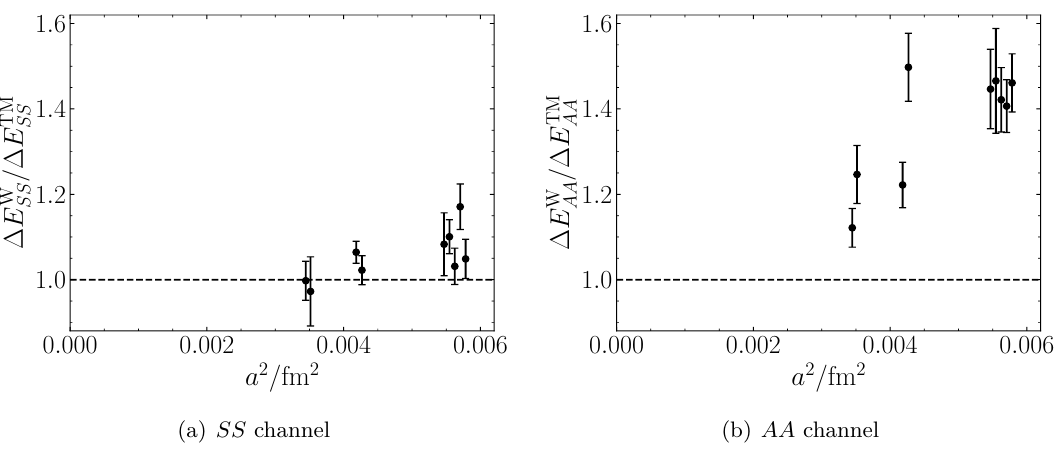
Figure 7 . Dependence on the lattice spacing of the quotient between the energy shifts computed using two different fermion regularizations: the Wilson setup and the mixed-action one. The comparison is done both for the SS (left) and AA (right)